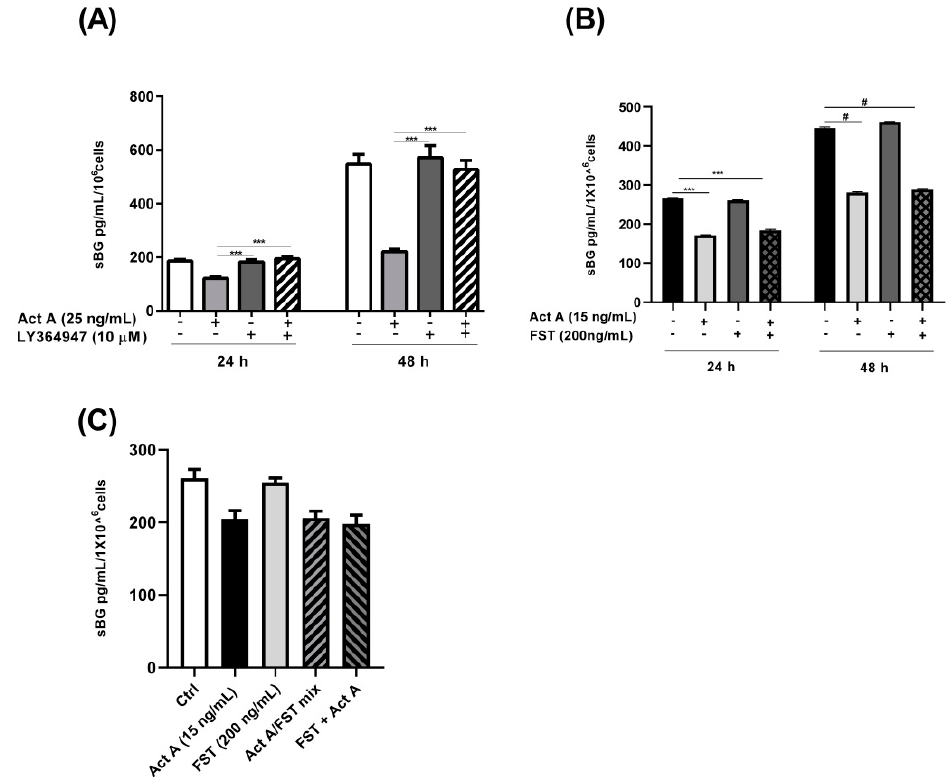
Figure 4. Activin A-mediated reduction in BG shedding is TGF- β type 1 receptor (ALK-4)-dependent but follistatin-independent. Epithelial 12Z cells were pre-incubated in the absence or presence of the ALK-4/5 inhibitor, LY364947 (10 µ M) ( A ), or follistatin (200 ng/mL) for 2 h (B ) or 30 min ( C ) prior to stimulation with activin A (25 ng/mL or 15 ng/mL) for 24 h and 48 h, or Activin A-follistatin mixture ( C ) for 24 h and supernatants were analyzed by sBG ELISAs. LY364947 completely abolished the reduction in BG shedding induced by activin A, whereas follistatin had no effect. Untreated cells or cells treated with DMSO (0.01%) were used as controls. Each bar represents the mean ± SEM of 3 independent experiments performed in duplicate. Dunnett’s test was used for statistical analysis; *** p < 0.001; # < 0.0001 ; sBG, soluble betaglycan; Act A, activin A; FST, follistatin; mix, mixture.